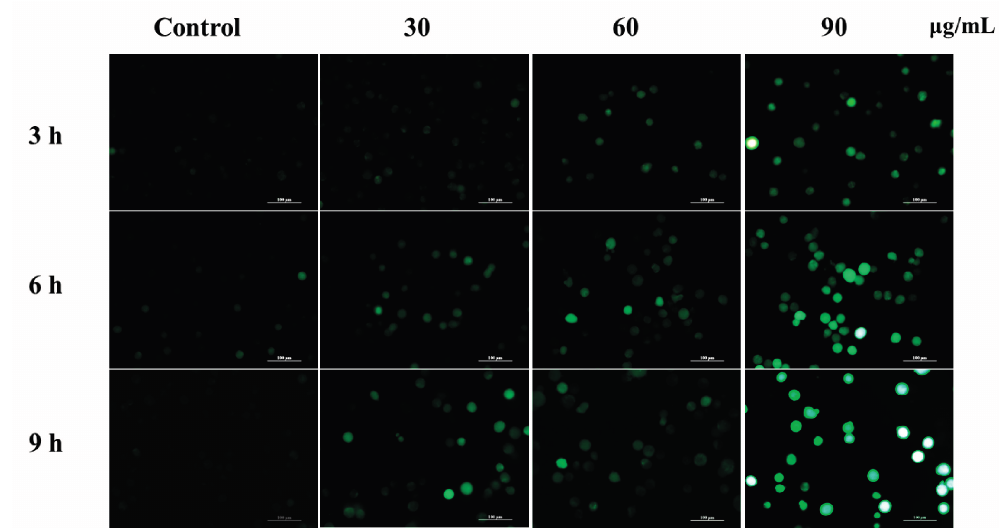
Figure 5. ROS generation induced by M. integrifolia . K562 cells were treated with M. intergrifolia for 3, 6 and 9 h. The intracellular ROS level was observed under fluorescent